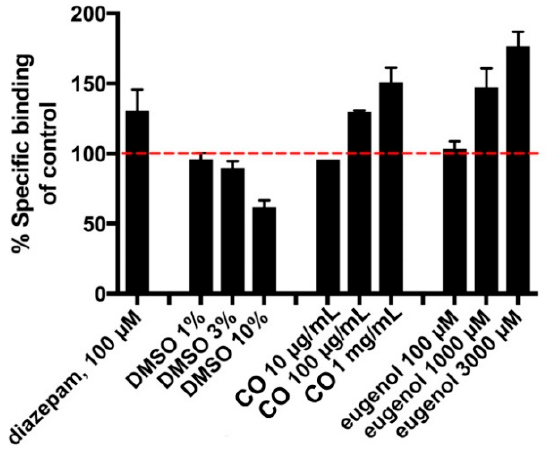
Figure 6. Effect of diazepam, DMSO (vehicle), CO, and eugenol on [ 3 H]muscimol binding. The red line denotes normal level of total [ 3 H]muscimol binding. Data are given as percentage of specific binding as means ± SD of triplicate measurements of a single representative experiment. An additional independent experiment gave similar results.